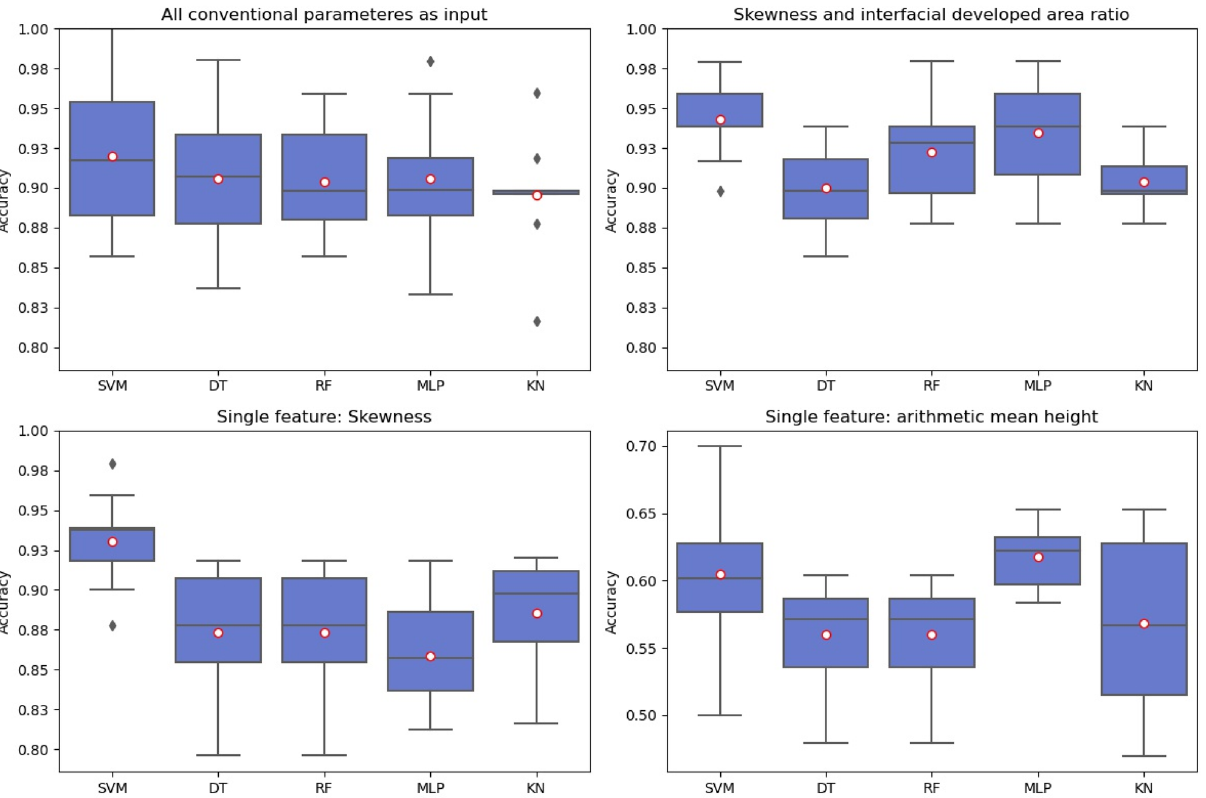
Figure 5. Conventional parameters and classification accuracy obtained for classifiers SVM, DT, RF, MLP, and KN after hyperparameter optimisation (input: all 7 conventional roughness parameters, skewness and developed interfacial ratio, only skewness, only arithmetic mean height). Mean values as red circles. Note the different y-limits for the accuracy values for the arithmetic mean height